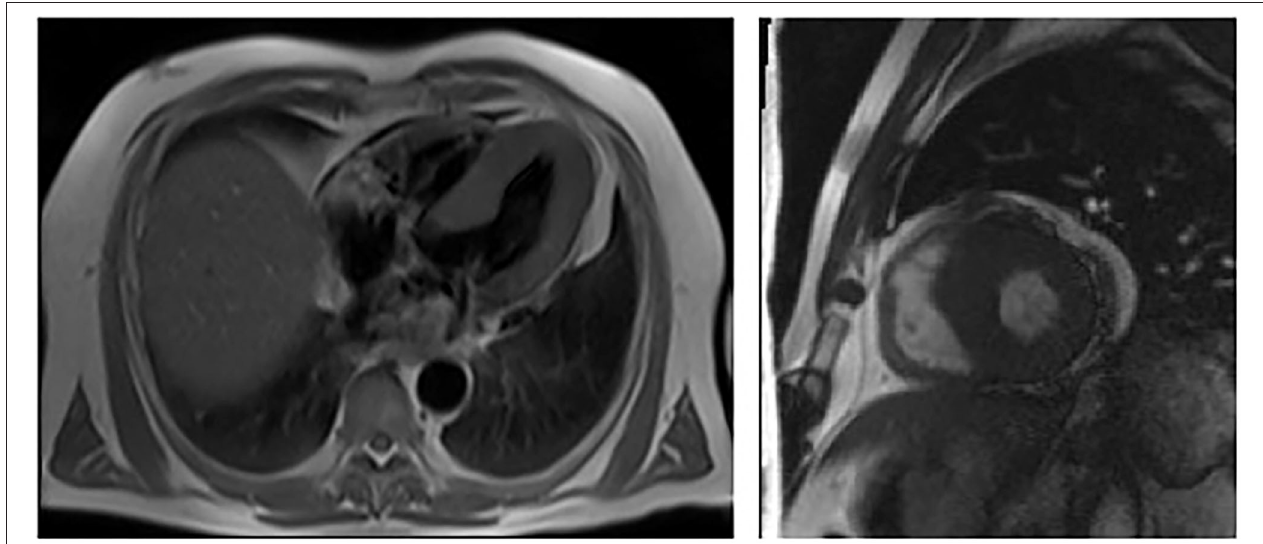
FIGURE 1 | Cardiac MRI showing left ventricular hypertrophy with no late enhancement of Gadolinium in patient 1 (III – 13, proband).